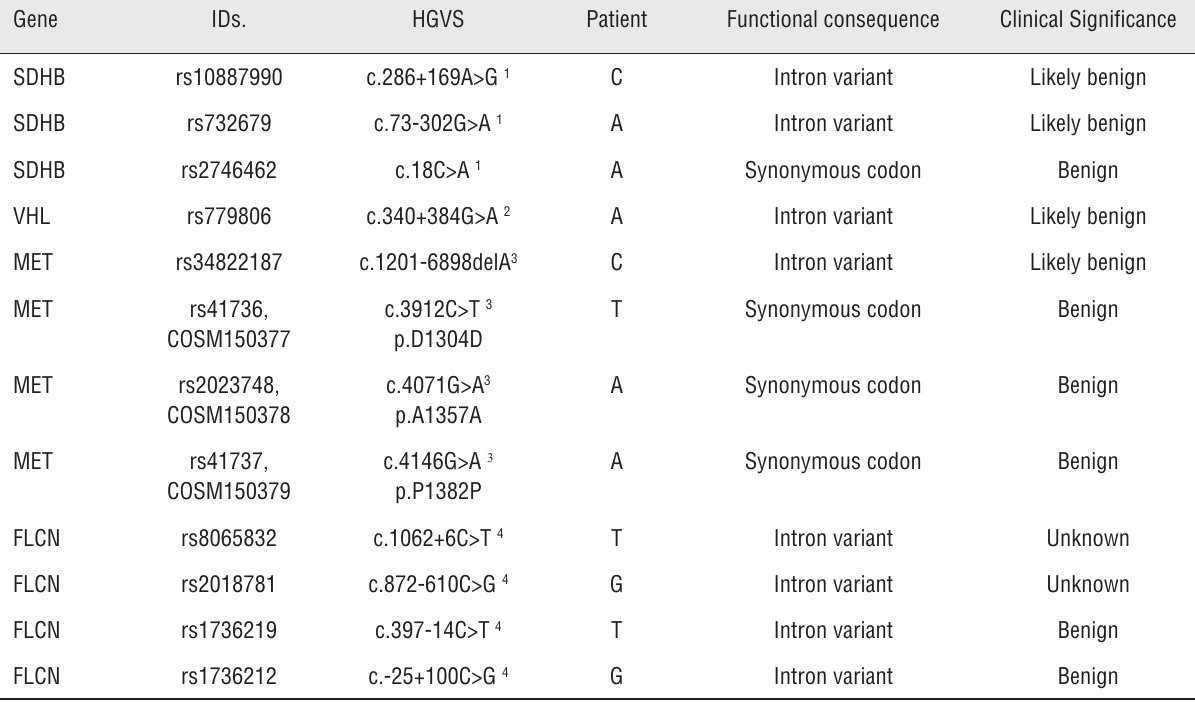
Table 2 - Sequence variants found in VHL, MET, FLCN, SDHB, and SDHD gene sequencing. Gene IDs.